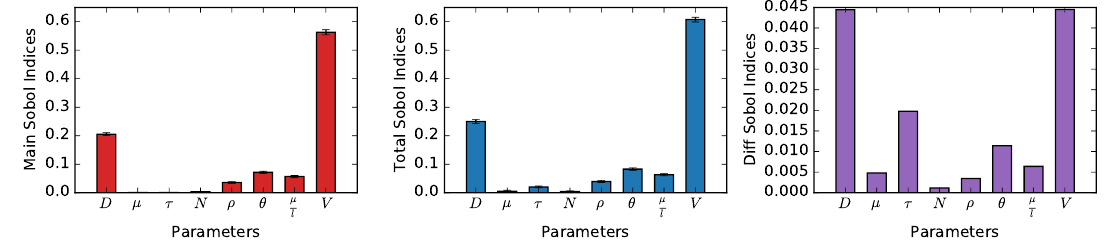
Figure 6. Mean values of the main and total Sobol’ indices obtained by 80,000 LHS samples of the 100 emulators with lowest RMS errors. Shown also are the differences between the main and total Sobol’ indices for each input parameter. Error bars show standard deviations about the mean. The input parameters, as shown along the x axis, are: submergence depth, D ( m ) ; viscosity, µ ( Pas ) ; yield stress, τ ( Pa ) ; shear thinning exponent, N ; density, ρ ( kgm − 3 ) ; slope angle, θ ◦ ; boundary layer parameter, µ ( kgm − 2 s − 1 ) ; and volume, V ( m − 3 ) l